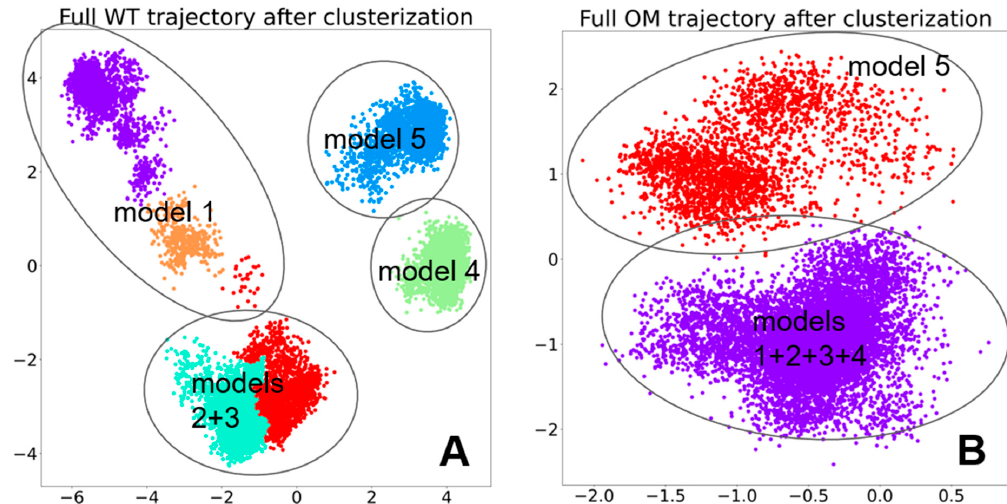
Figure 4. Clusterization results of the first two principal components of WT ( A ) and OM ( B ) RBM conformations in dPCA space. Clusters assigned with corresponding AlphaFold models (starting conditions).